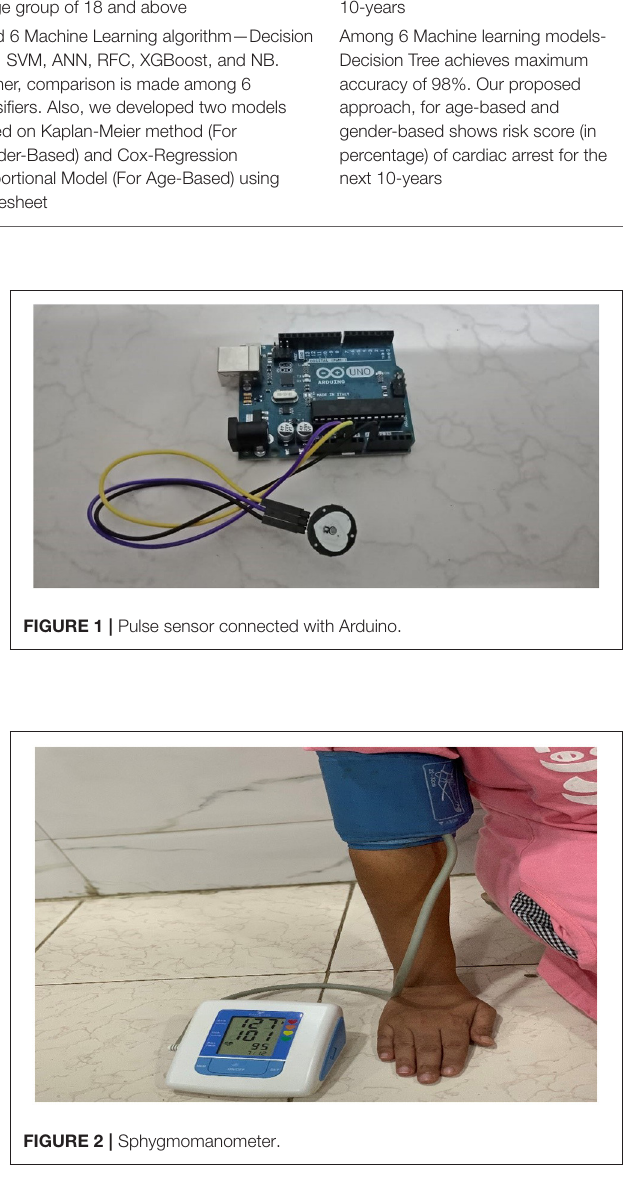
cardiac arrest prediction. Figures 1 – 3 show measuring device used for capturing vital